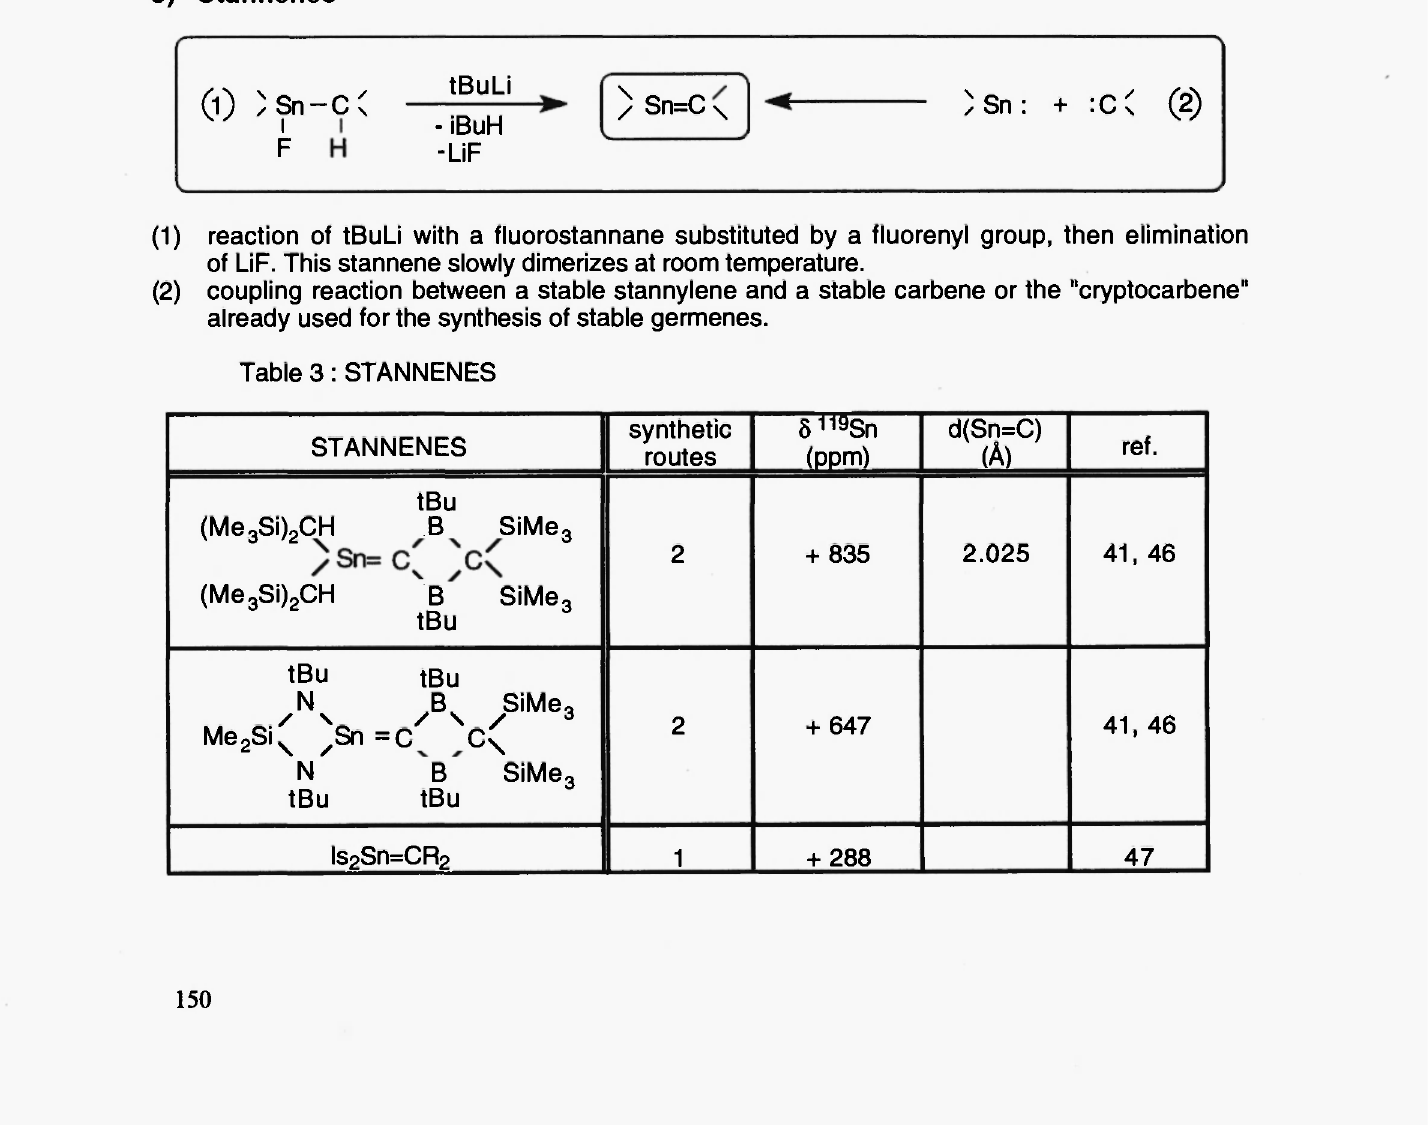
Table 3: STANNENES STANNENES